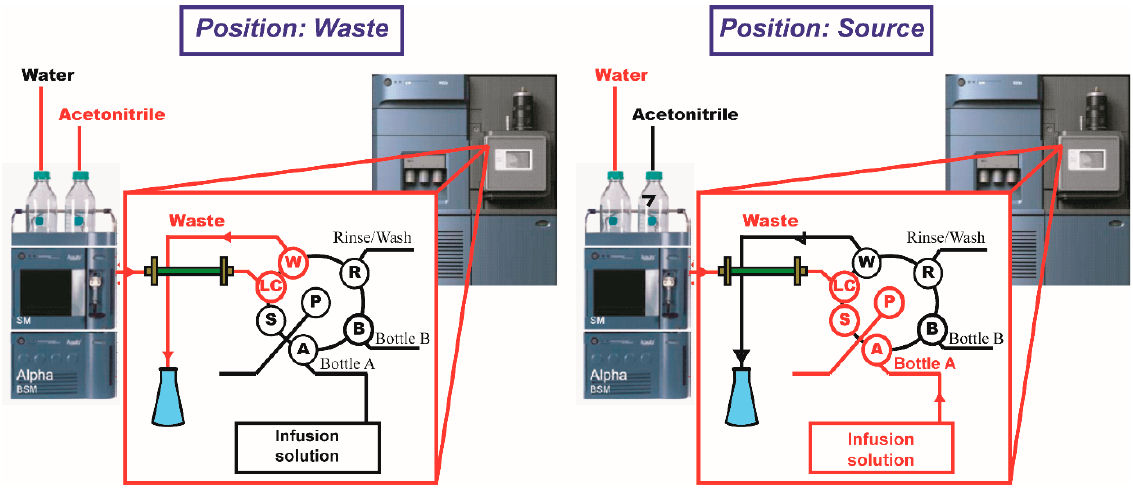
Figure 3. In-tube SPME-MS/MS system using the MS detector valve with post-capillary infusion. Miranda et al. [12] used a post-capillary infusion with acetonitrile containing 2% ( v / v ) formic acid (during elution step) to increase the MS/MS